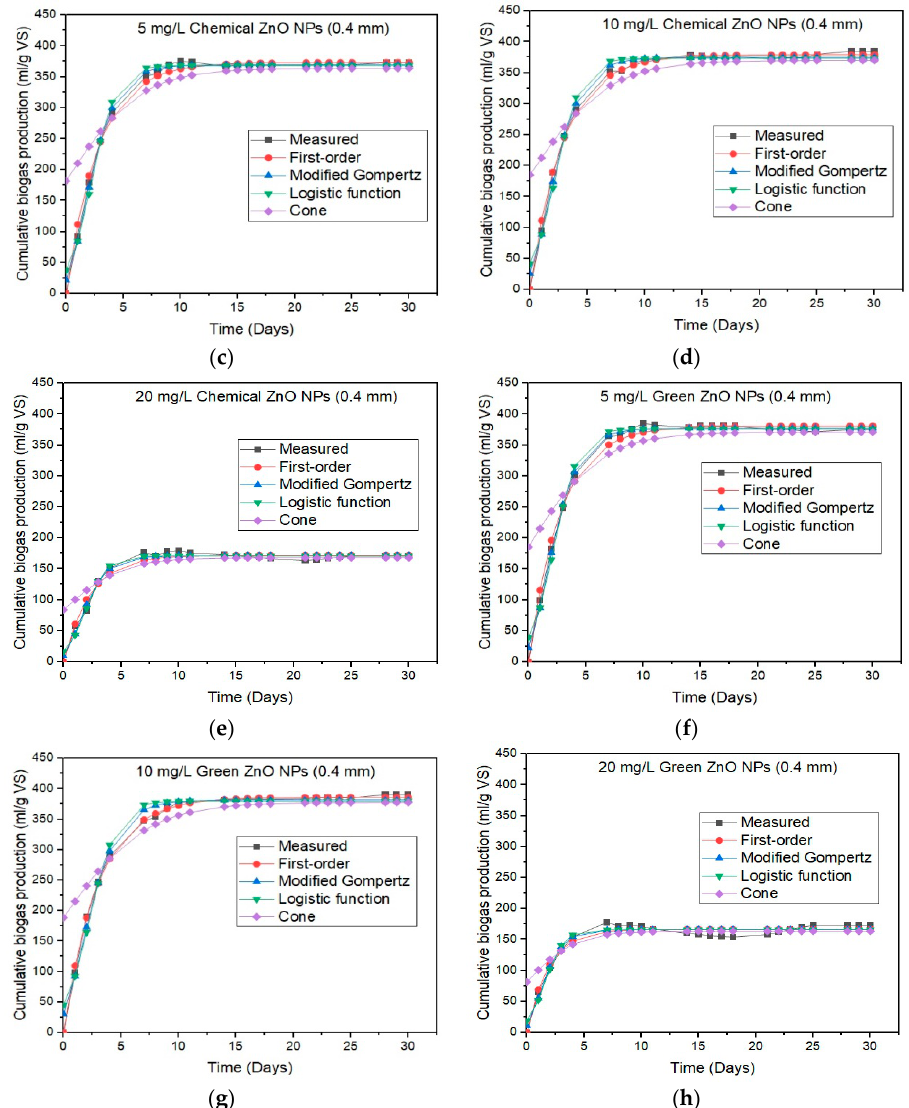
Figure 14. Cumulative biogas yield from the four studied models. ( a ) 0 mg/L ZnO NPs (4 mm); ( b ) 0 mg/L ZnO NPs (0.4 mm); ( c ) 5 mg/L chemical ZnO NPs (0.4 mm); ( d ) 10 mg/L chemical ZnO NPs (0.4 mm); ( e ) 20 mg/L chemical ZnO NPs (0.4 mm); ( f ) 5 mg/L green ZnO NPs (0.4 mm); ( g ) 10 mg/L green ZnO NPs (0.4 mm); ( h ) 20 mg/L green ZnO NPs (0.4 mm).